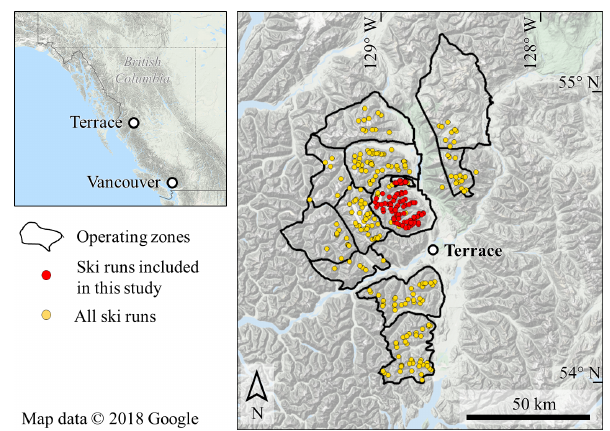
Figure 2. Overview of the study site with location of the tenure region and the ski runs for one of the operating zones included in this